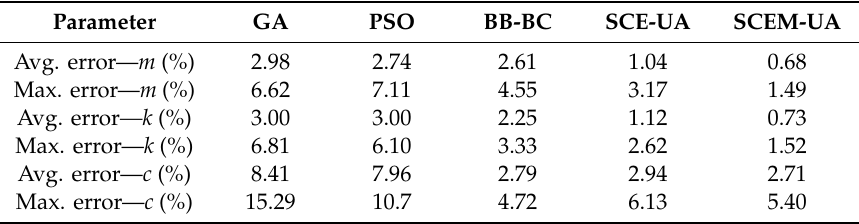
Table 5. Average error (avg. error) and maximum error (max. error) between the parameter value found with the lowest posterior probability and the true value.